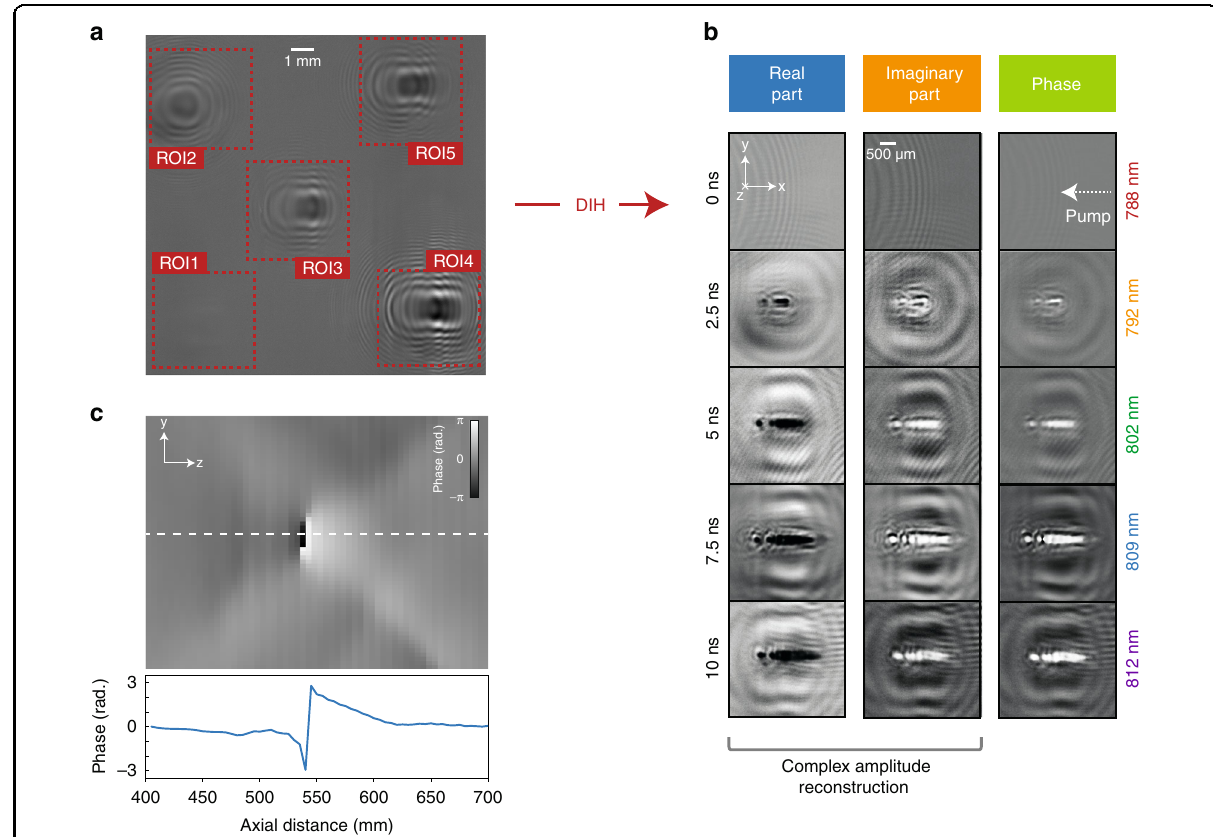
Fig. 6 Image reconstruction using digital in-line holography (DIH). The concept of lensless AOPDF-based SF-STAMP based on DIH is demonstrated by imaging laser-induced air breakdown on the ns scale. a Hologram normalized by background subtraction. b Complex amplitude and phase reconstruction using DIH (based on the hologram of a). The image is reconstructed at an axial distance z r = 550 mm and the asymmetrical plasma expansion is clearly seen. c Phase map along the longitudinal axis obtained by reconstructing the complex amplitude and calculating the phase at different longitudinal coordinates. The selected zone of interest is the leftmost spot in the air breakdown pattern in b . The phase variation along the optical axis (blue solid line) is a striking signature of the actual location of the intensity and phase